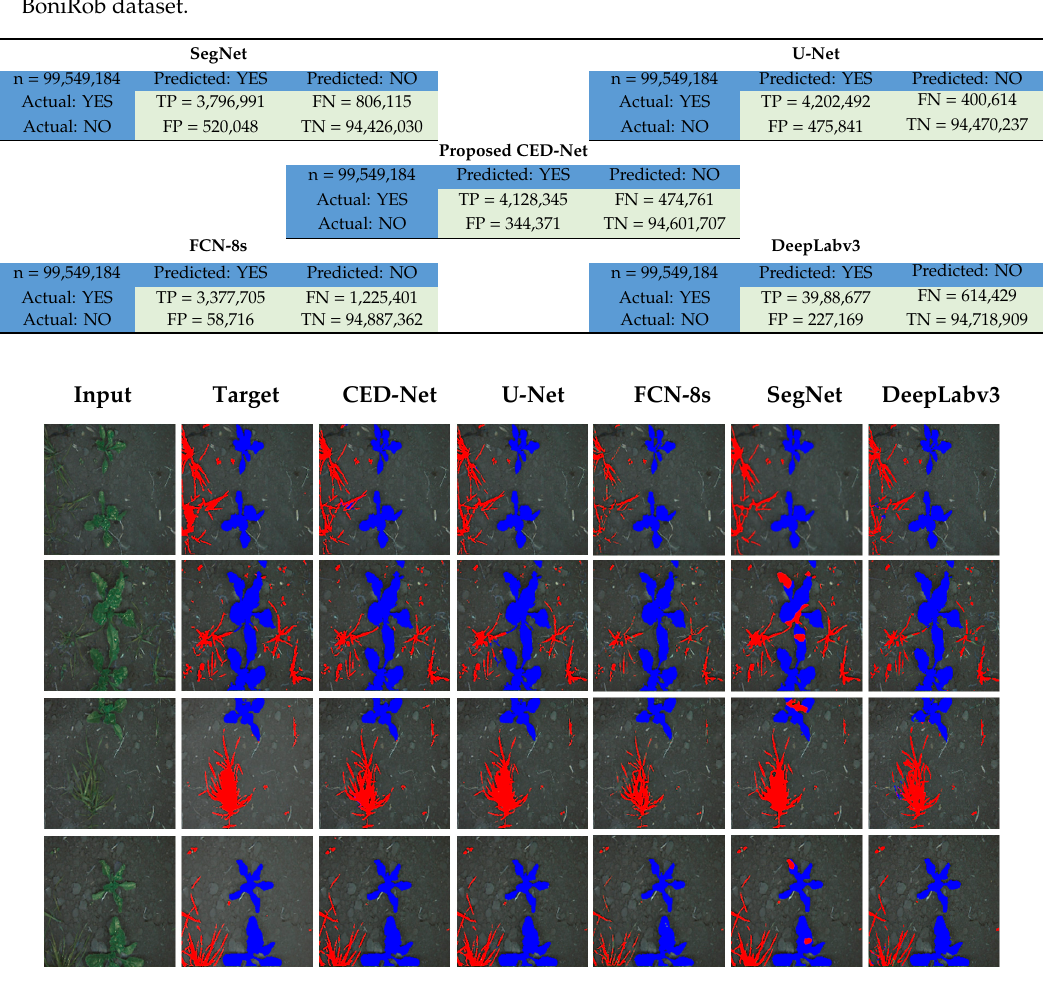
Table 6. Confusion matrices of SegNet, U-Net, FCN-8s, DeepLabv3, and proposed CED-Net for BoniRob dataset.